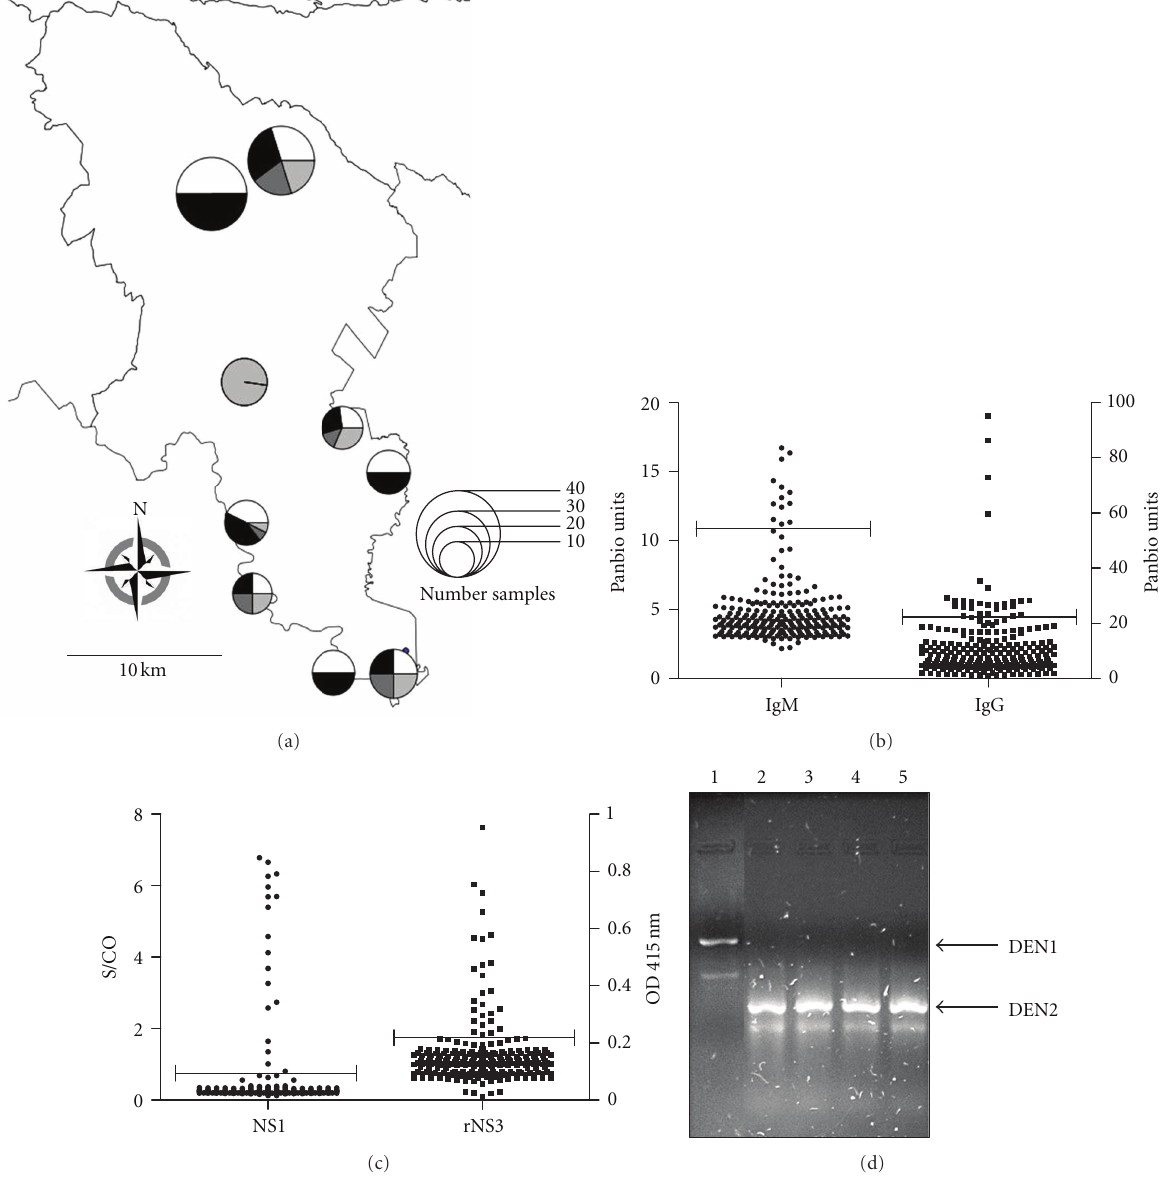
Figure 3: Seroprevalence and serotyping of dengue virus. (a) Geographical distribution of cases in the municipality of Tezonapa; the circles on the map indicate the villages, with their size proportional to the number of samples as indicated on the map, white areas represent IgG- positive samples, dark gray areas represent IgM-positive samples, light gray areas represent NS1-positive samples, and black areas represent NS3-positive samples. (b) Identification of positive samples for IgM and IgG by ELISA (Panbio). (c) NS1 antigen detection (Bio-Rad) and identification of NS3-positive samples by ELISA (in-house detection system). (d) Serotyping of dengue virus by RT-PCR, lanes 1–5 representative samples from rural villages; heat arrow indicates PCR product by DEN 1 and DEN